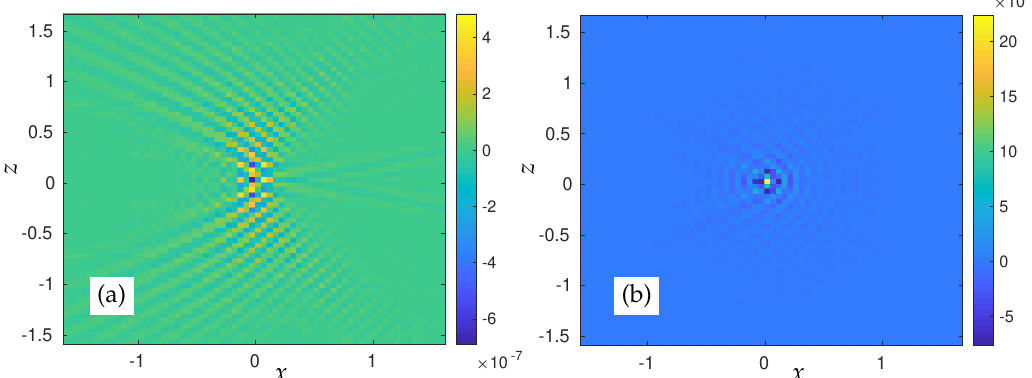
Figure 10. Sweeping effect of a homogeneous horizontal mean velocity field on the Saint Andrew’s cross pattern of propagation of internal gravity wave after filtering the wave and eddy component of vertical velocity u z : ( a ) wave part u w z ( x , t ) ; and ( b ) eddy part u e z ( x , t )